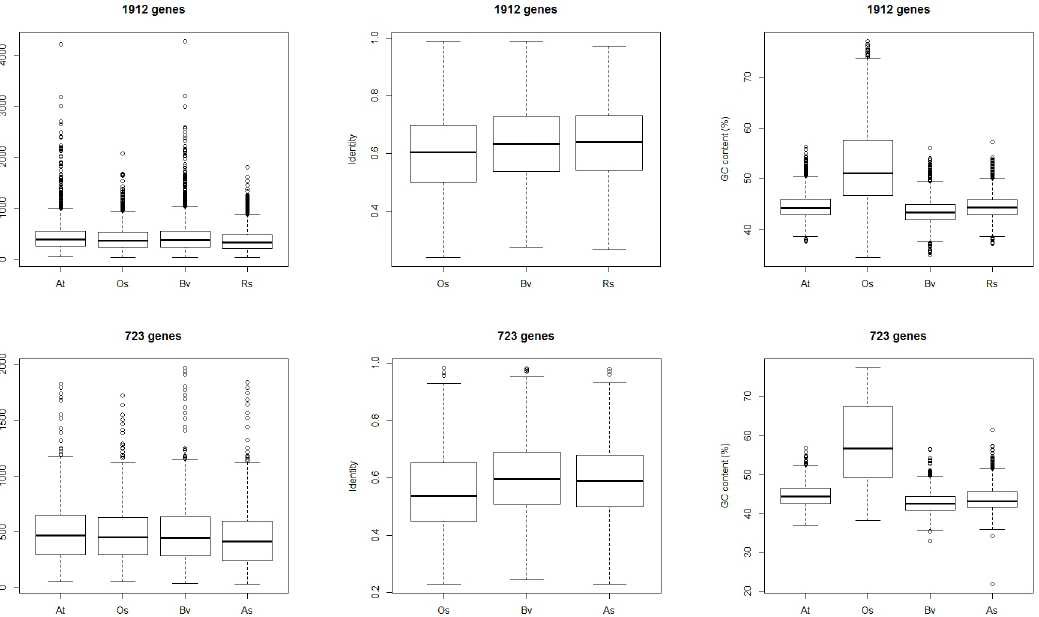
Fig 4. Characteristics of the species-specific conserved and lost gene sets. A total of 1912 genes were conserved in R . soongorica but lost in sand rice, whereas 723 genes were conserved in sand rice but lost in R . soongorica